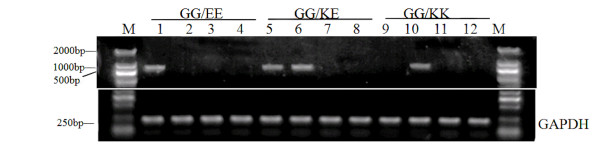
ICAM-1 G241R and K469E genotypes. Lane M: Marker; Primers: G241-E469 (lane 1,5,9); G241-K469(lane 2,6,10); R241-E469(lane 3,7,11); R241-K469 (lane 4,8,12).